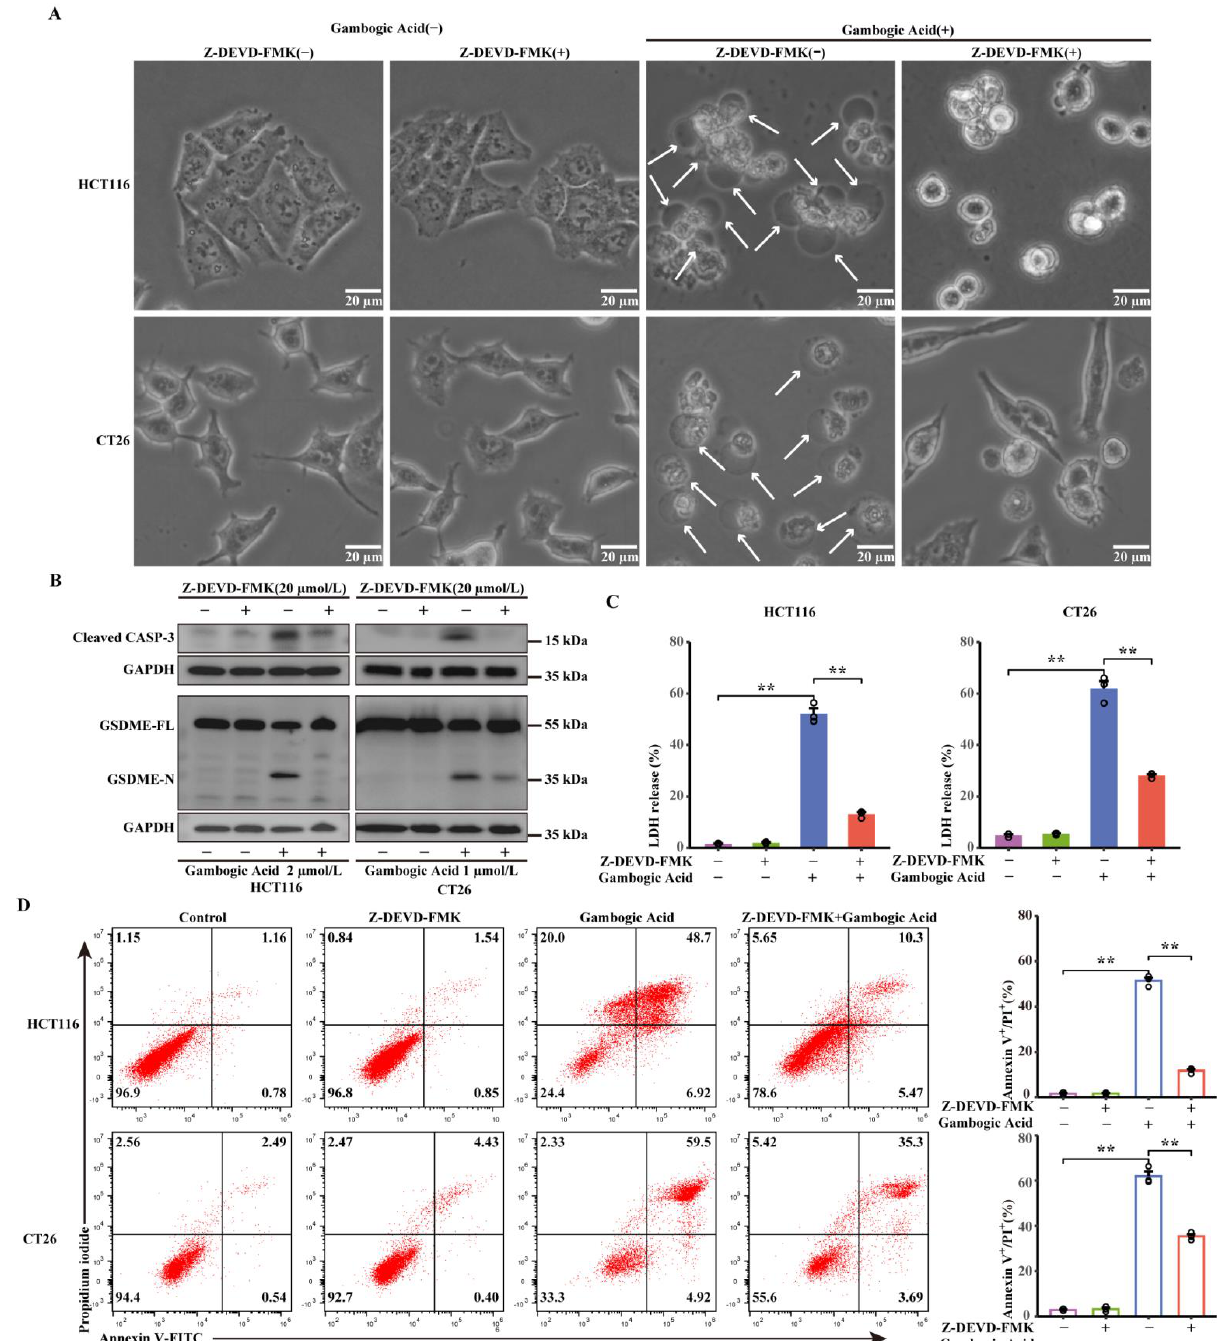
Figure 6. Caspase-3 is essential for GSDME-dependent pyroptosis. ( A ) Representative bright-field images of HCT116 and CT26 cells after treatment with GA (2 µ mol/L or 1 µ mol/L, 12 h) in the presence or absence of Z-DEVD-FMK (20 µ mol/L). The white arrows point to pyroptotic cells. ( B ) GSDME and Cleaved caspase-3 expression levels were analysed by western blotting. The whole western blots were shown in Figure S5. ( C ) The release of LDH and ( D ) flow cytometric analysis were performed after treatment of GA in the presence or absence of Z-DEVD- FMK (20 μmol/L). The cells were exposed to 0.1% DMSO as control. All experiments were repeated three times and results were expressed as mean ± SD. ** p < 0.01 vs. control.